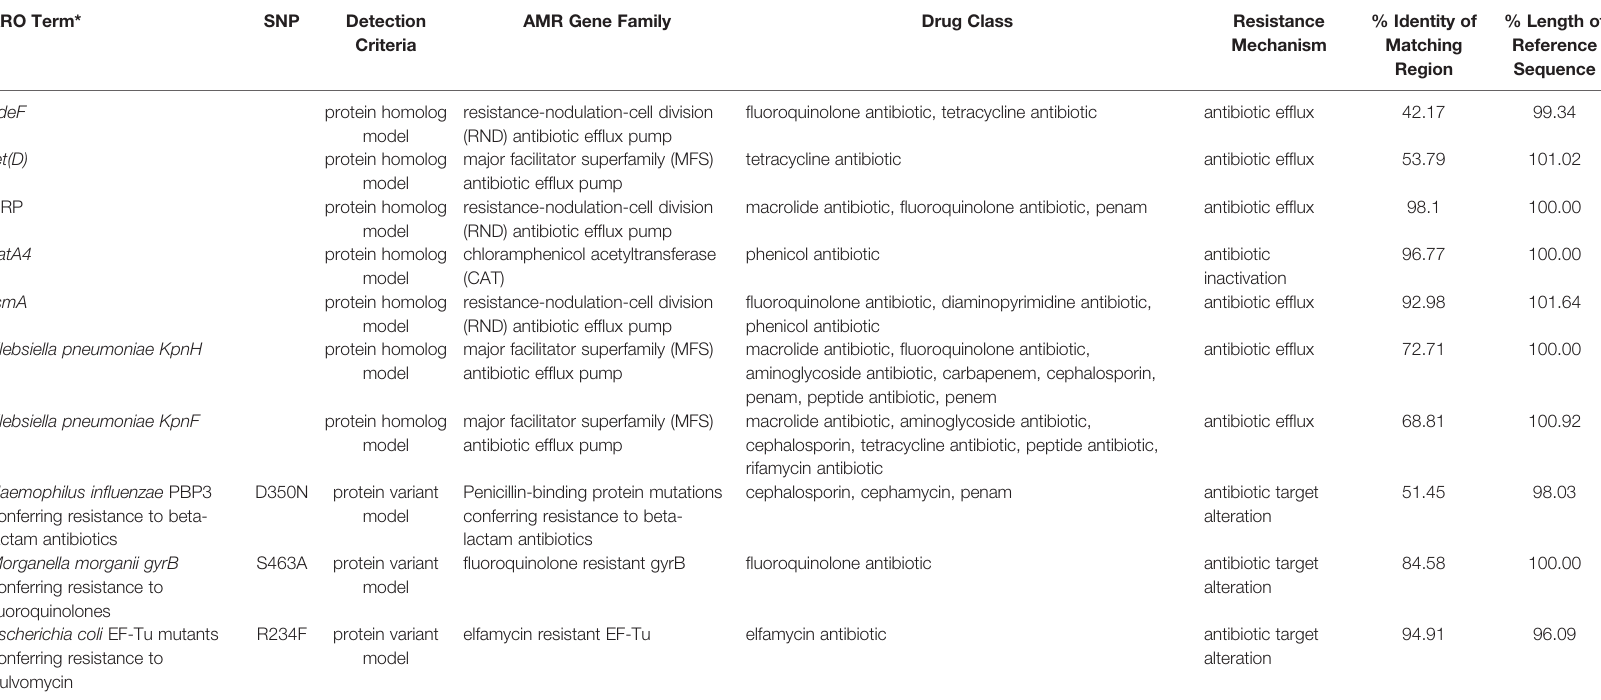
TABLE 7 | The putative antibiotic resistance genes identi fi ed in genome of P. mirabilis PrK 34/57 by the Resistance Gene Identi fi er (RGI) based on the Comprehensive Antibiotic Research Database